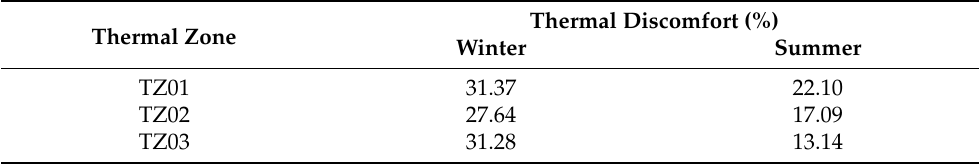
Table 8. Thermal discomfort—Scenario